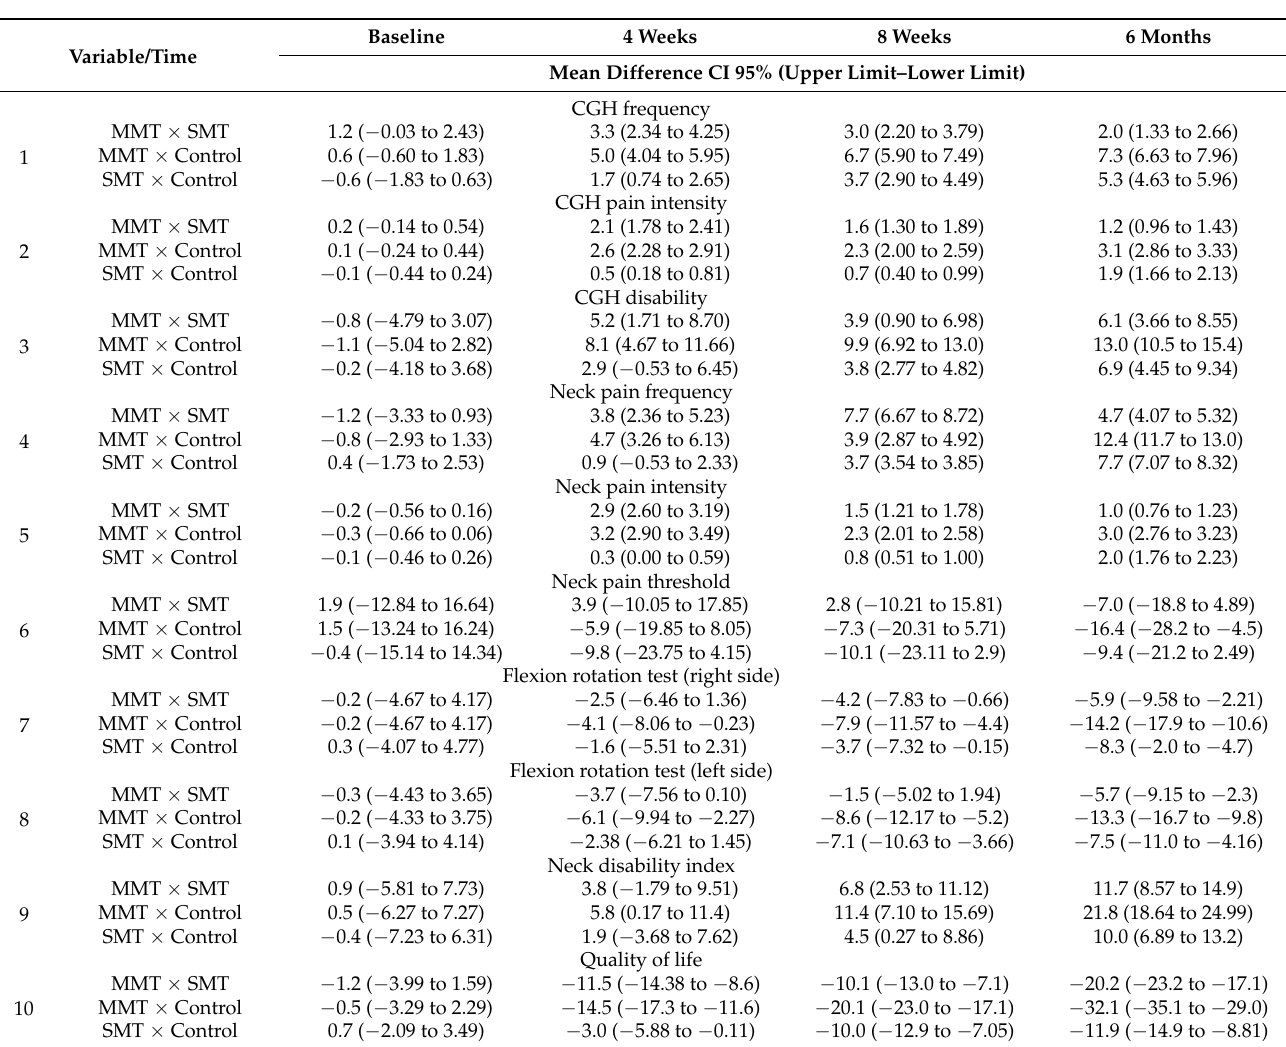
Table 3. Pre- and post-mean difference and confidence interval (upper limit and lower limit) scores of MMT, SMT, and control